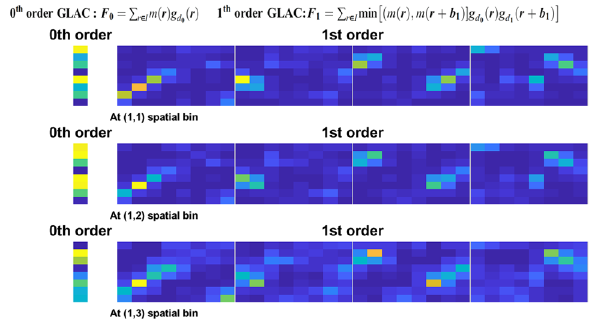
Fig. 7 Example of 0th and 1th order GLAC